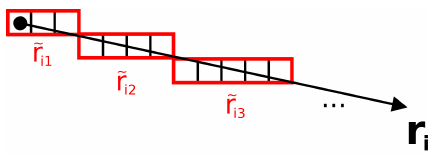
Figure 2. Runs ˜r i1 , ˜r i2 , ˜r i3 of the line prototype of shape r i with a length of three (truncated start segment), four and five pixels